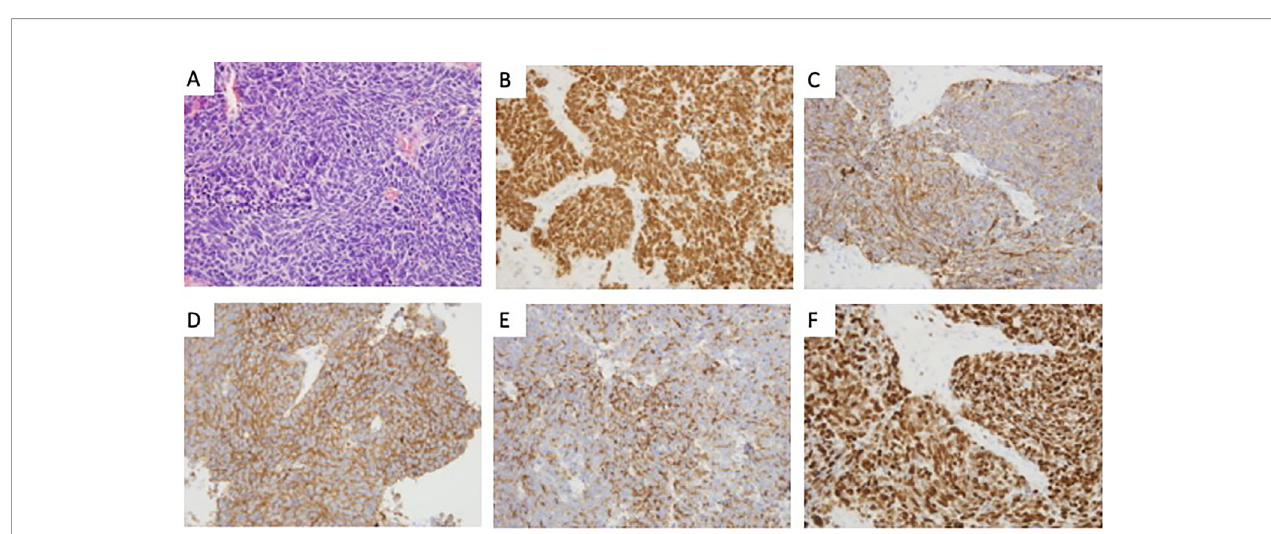
FIGURE 3 | The histological features of the lesion revealed pituitary metastasis of lung neuroendocrine. (A) Hematoxylin and eosin (H&E) staining revealed a solid tumor involving the pituitary gland, characterized by small cells with high-grade nuclear atypia and fi brosis (×400); (B – E) Immunohistochemistry revealed positivity for TTF-1(B), CK(C), Syn(D), and CgA(E) (×400); (F) Immunohistochemical staining of Ki-67 (×400).